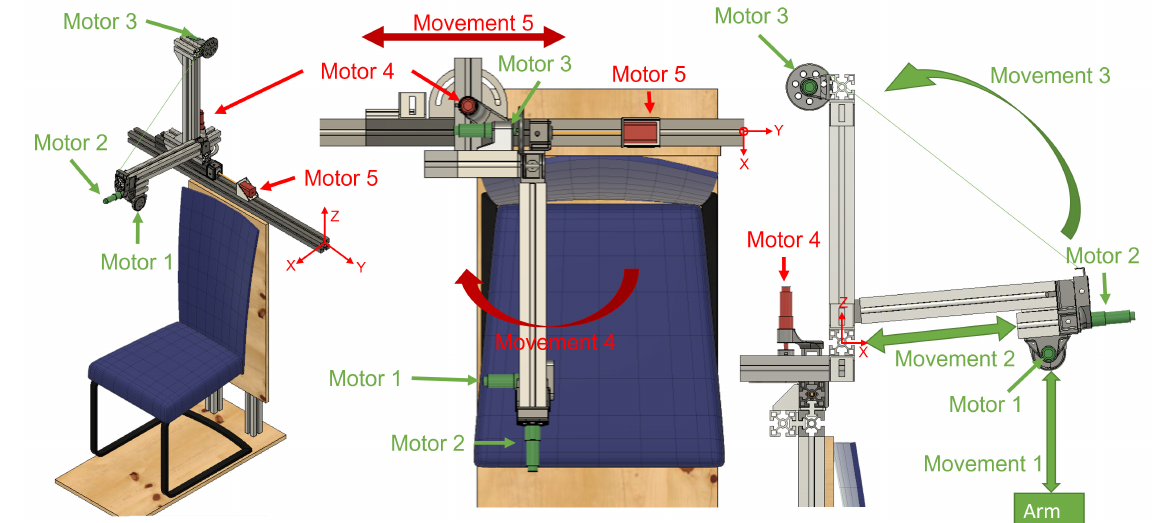
Figure 1. Views of the hybrid exoskeleton developed for arm rehabilitation treatments. Active joints during patient rehabilitation are shown in green; joints for the adjustment of the structure are shown in red. The origin of the system is marked in the three